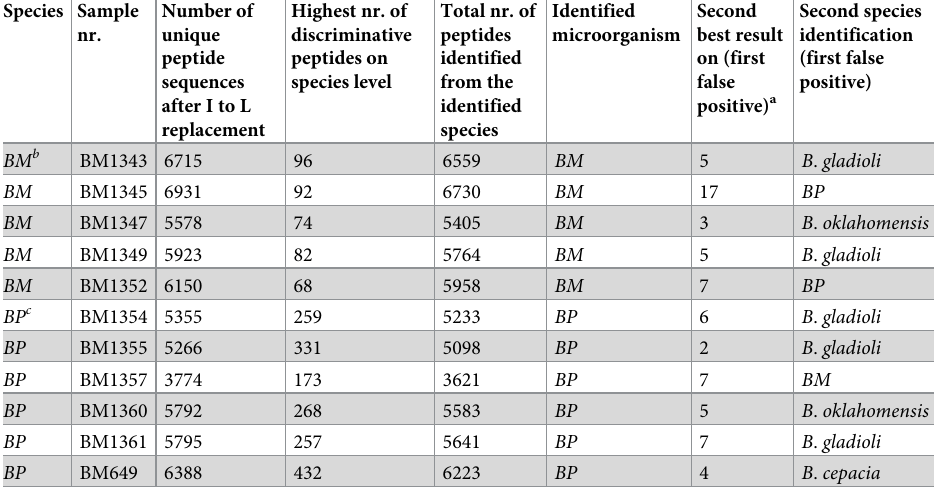
a Second highest number of discriminative peptides on species level b BM: B . mallei c BP: B . pseudomallei